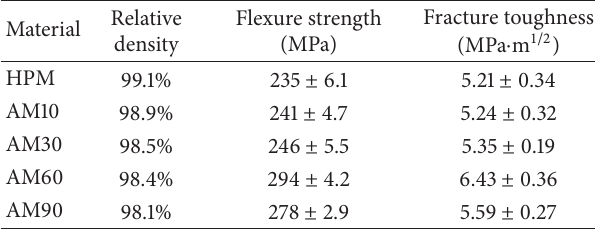
Table 1: Mechanical properties of hot-press sinter and annealed specimen of C w /SiC